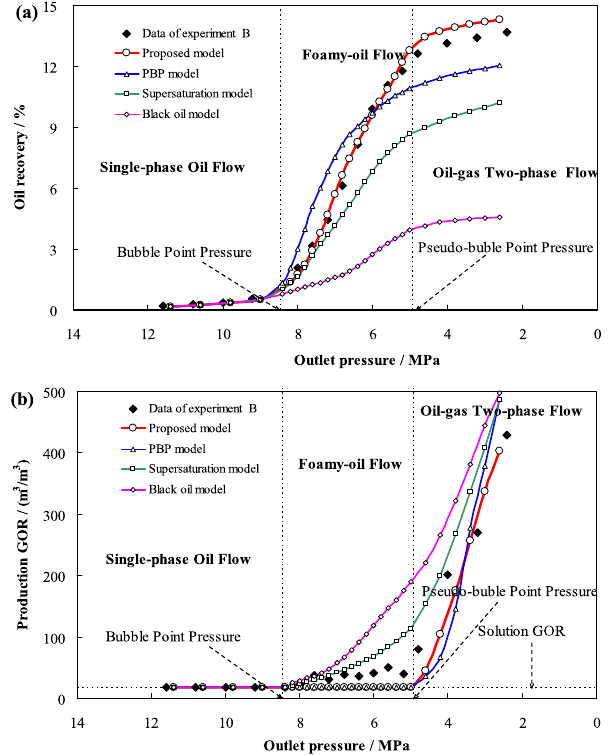
Figure 5. The simulated results by the four models in comparison with the experimental data for experiment B. ( a ) Oil recovery with respect to outlet pressure. ( b ) Production GOR with respect to outlet